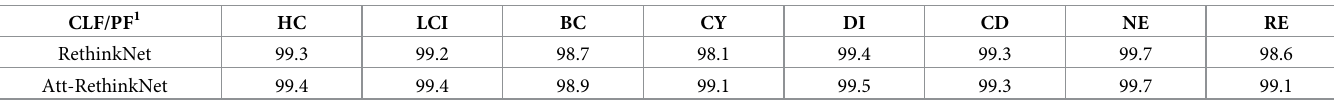
Table 6. ACC lab of all pathological findings for RethinkNet and Att-RethinkNet in kidney data. CLF/PF 1 HC